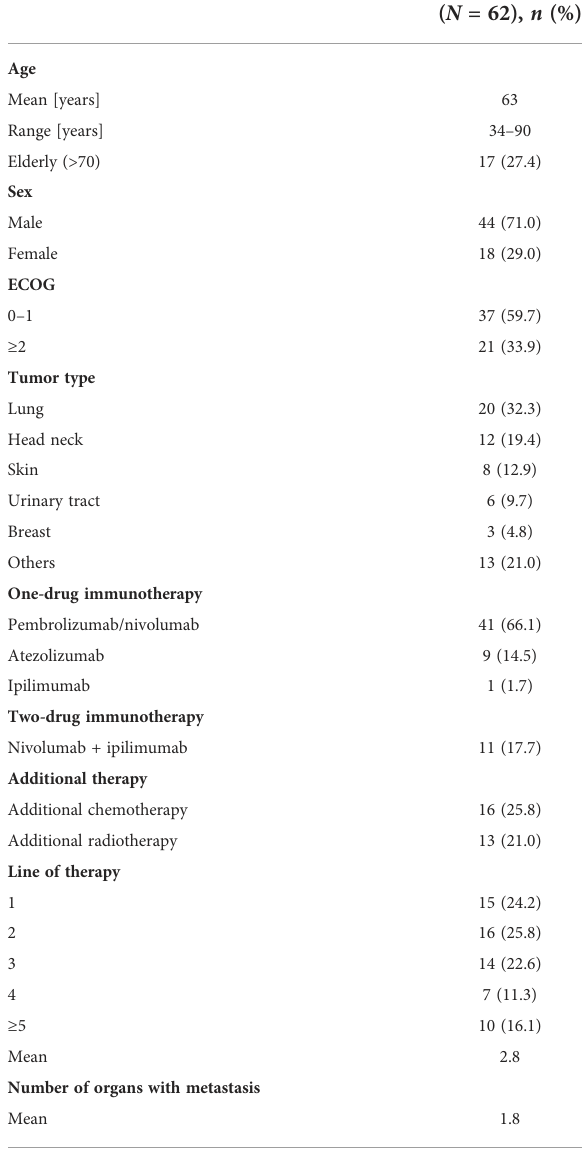
TABLE 1 Patient